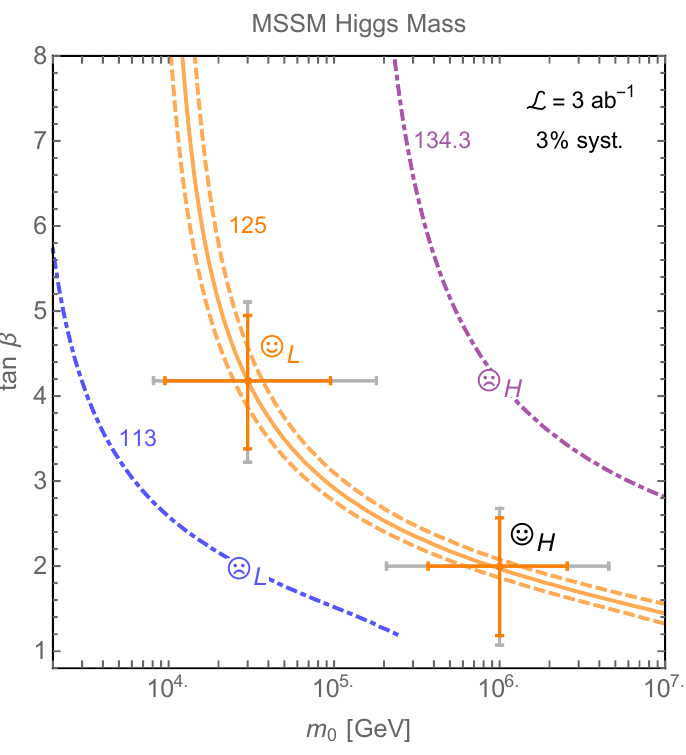
Figure 13 . Expected accuracy in measurement of m 0 and tan (cid:12) for two parameter points consistent with m h = 125 GeV within the MSSM. The error bars correspond to 1 (cid:27) statistical uncertainty (orange) and an additional 3% systematic uncertainty (gray). We chose the luminosity to be L = 3 ab (cid:0) 1